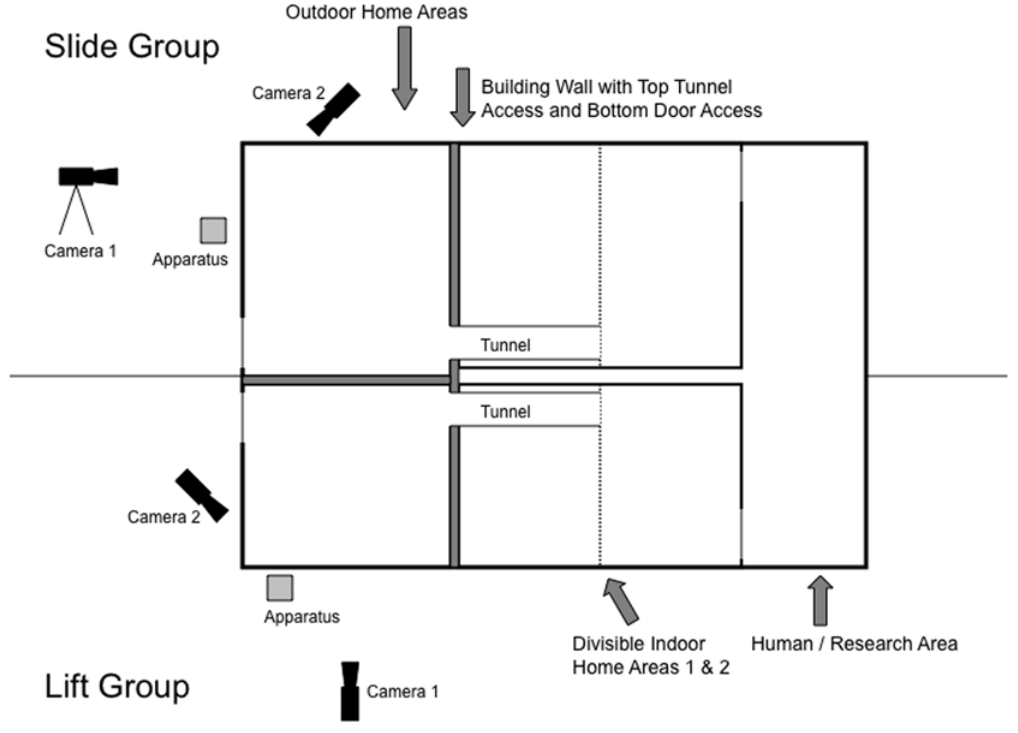
Figure 2. Testing Areas. A floor plan showing the outdoor areas for each group and the locations of video cameras and Doorian foraging device. Thick partitions are opaque, so each group cannot see the